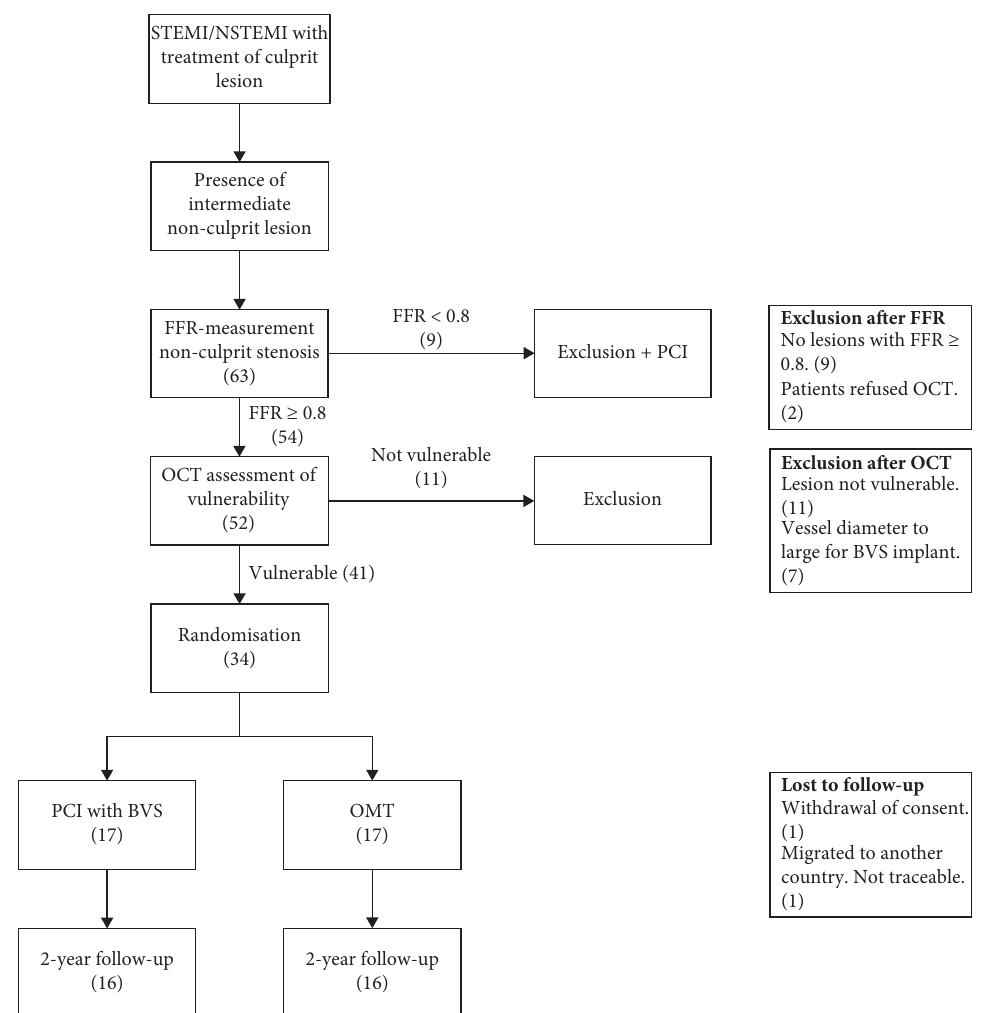
Figure 1: Study Flowchart. BVS, bioresorbable vascular scaffold, FFR, fractional flow reserve, NSTEMI, non-ST-elevation myocardial infarction, OCT, optical coherence tomography, OMT, optimal medicinal therapy, PCI, percutaneous coronary intervention, STEMI, ST- elevation myocardial (Table 3) were as follows: the average fibrous cap thickness